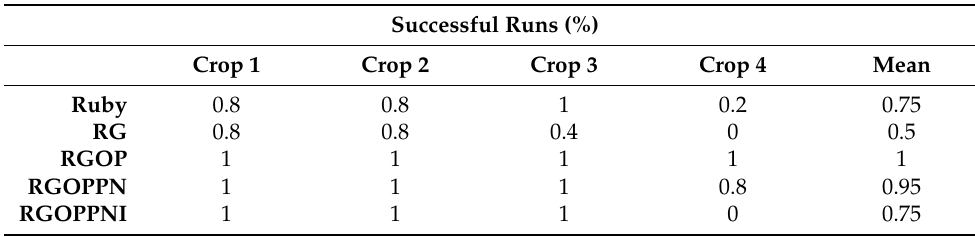
Table 2. The ratio of successful runs regarding the total number of tries (five, in this case). A result of 1 means that the algorithm never failed, a result of 0 means that the robot never reached the end of the field without crushing crop plants.